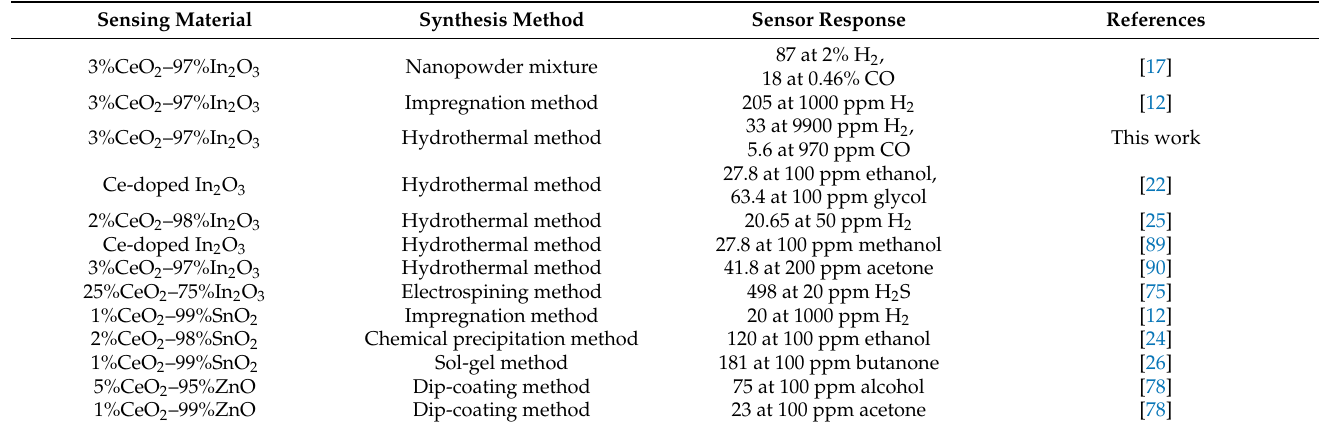
Table 2. Sensor response to various gases of composites with CeO 2 additives.